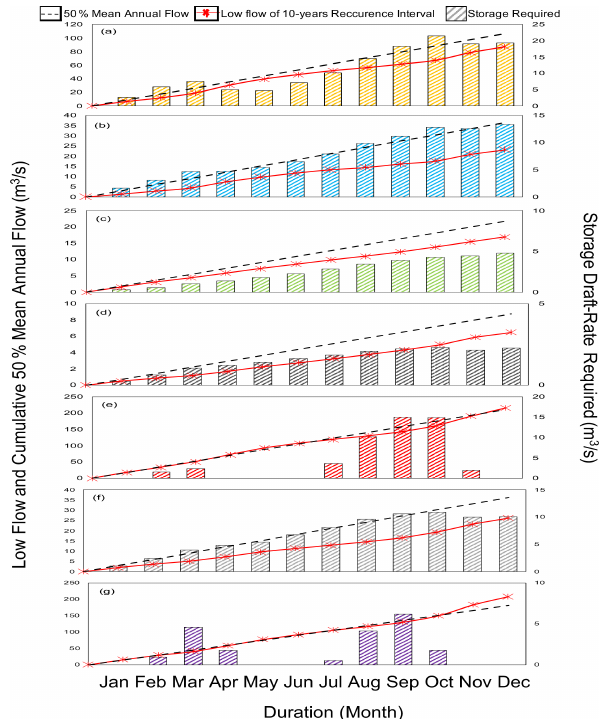
Figure 6. Minimum storage draft rate with a cumulative 50% mean flow at (a) S01, (b) S02, (c) S03, (d) S04, (e) S05, (f) S06 and (g)